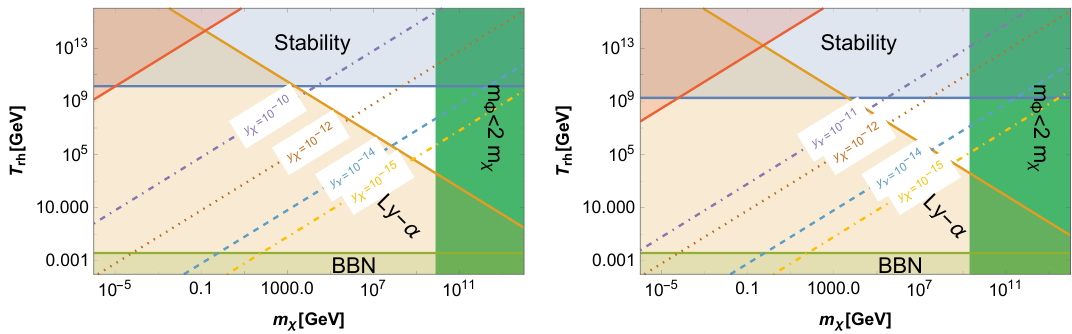
Figure 6. The allowed region (unshaded) for the Yukawa-like coupling y χ to produce the entire CDM of the present universe: left panel is for Model I inflation and right for Model II inflation. The constraints (colored regions) are from (a) BBN (light green colored region): T ity (blue colored region): T 1 . 388 × 10 10 GeV (for Model I) or T rh ’ from the upper bound of λ from eq. (3.9) or eq. (3.16), (c) stability (red-colored region): from 12 the upper bound of y from eq. (3.11) or eq. (3.19), (d) (deep green region): m χ (Model I) or < m 2 (Model II), (e) (light peach-colored region): Ly- α : T ϕ / T rh & (2 m ϕ ) /m χ